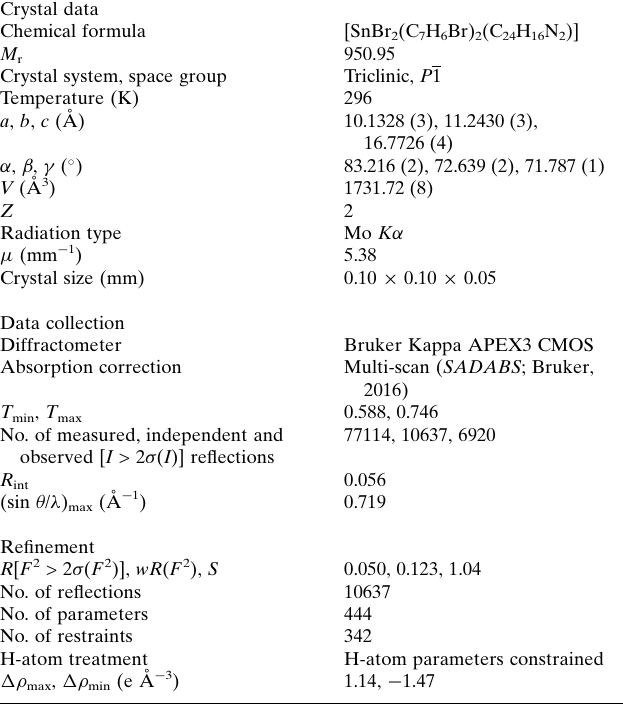
Experimental details. Crystal data Chemical